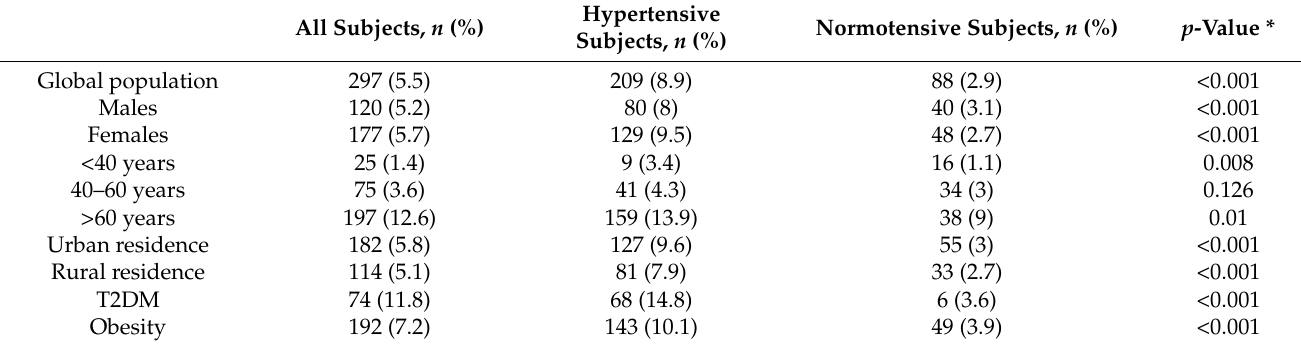
Table 1. Overall and subgroup atrial fibrillation prevalence in SEPHAR II, III and IV surveys in the presence and the absence of hypertension, respectively. * = p -value for prevalence comparison in hypertensive versus normotensive subjects, T2DM = type 2 diabetes mellitus, BMI = body mass